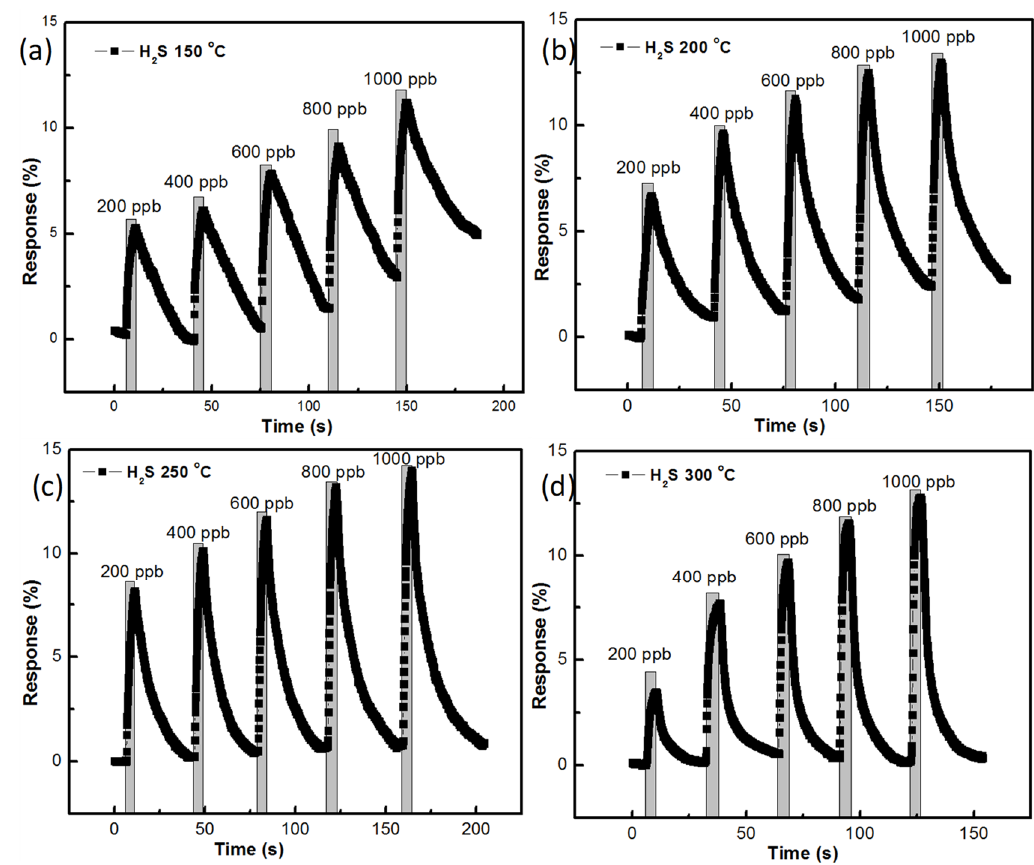
Figure 10. H 2 S gas-sensing response of ZnO nanostructure prepared with 90 min growth time: ( a ) at 150 °C, ( b ) 200 °C, ( c ) 250 °C, ( d ) 300 °C.